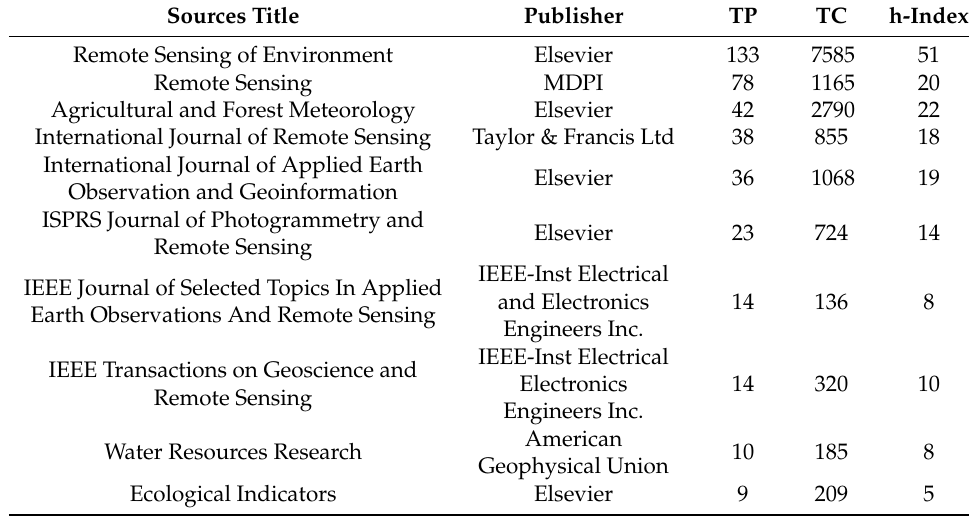
Table 6. Most active source (journal) titles.